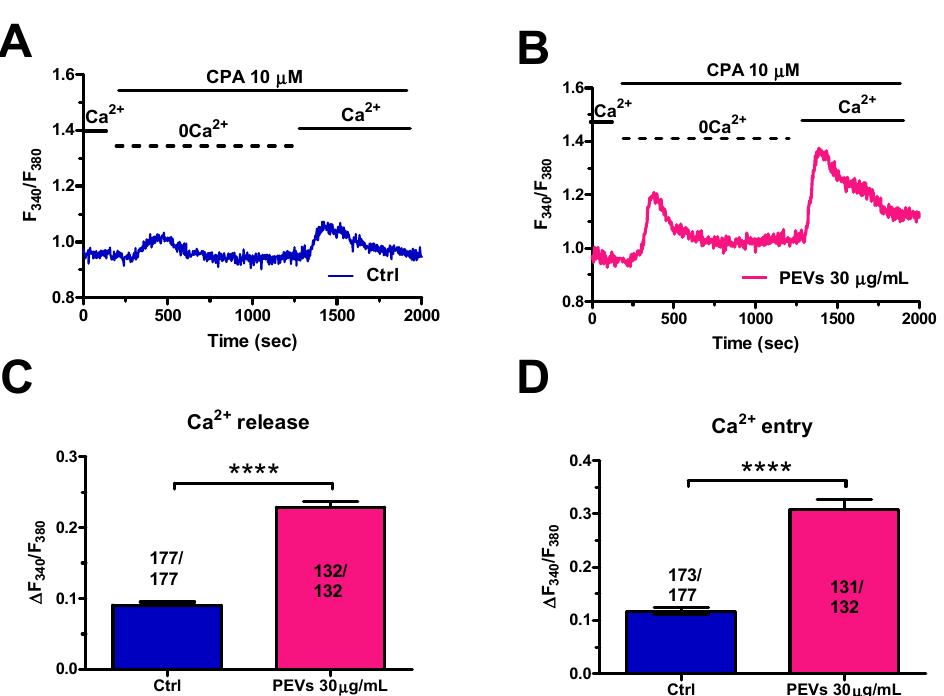
Figure 1. Long-term exposure of MDA-MB-231 cells to PEVs increases ER Ca 2+ mobilization and SOCE activation. ( A ). Control (Ctrl) cells were challenged with CPA (10 μ M), a selective SERCA inhibitor, in the absence of extracellular Ca 2+ (0Ca 2+ ). This manoeuvre caused a transient increase in [Ca 2+ ] i due to the depletion of the intracellular ER Ca 2+ store. The restoration of extracellular Ca 2+ induced a second increase in [Ca 2+ ] i , which is representative of SOCE. ( B ). Cells treated for 24 h with PEVs (30 µ g/mL) showed a higher Ca 2+ transient when stimulated with CPA under 0Ca 2+ conditions. Likewise, the restoration of extracellular Ca 2+ induced an enhanced increase in [Ca 2+ ] i that is indicative of a greater SOCE. ( C ). Mean ± SEM of the CPA-dependent intracellular Ca 2+ mobilization in control and PEV-treated cells. **** indicate p < 0.0001. ( D ). Mean ± SEM of the CPA-dependent SOCE amplitude in control and PEV-treated cells. **** indicate p < 0.0001. The migratory mechanism in MDA-MB-231 cells exposed to chemotactic cues involves an initial phase of Ca 2+ release from the ER through InsP 3 Rs followed by SOCE activa- tion [26,30,31,52,53]. Adenosine triphosphate (ATP) represents an autocrine/paracrine mes- senger that has long been used to evaluate InsP 3 -dependent Ca 2+ signals in multiple types of cancer cells [23,40,53,54], including MDA-MB-231 cells [55,56]. ATP binds to G q -coupled P 2Y receptors, thereby stimulating phospholipase C β (PLC β ) to cleave phosphatidylinositol- 4,5-bisphosphate (PIP 2 ) into diacylglycerol (DAG) and InsP 3 [23,40,54,57]. Preliminary experiments confirmed that ATP-evoked intracellular Ca 2+ release was mediated by InsP 3 Rs (Figure S2). The Ca 2+ add-back protocol confirmed that both phases of the Ca 2+ response to ATP (100 µ M), i.e., intracellular Ca 2+ release through InsP 3 Rs and SOCE, were significantly enhanced in MDA-MB-231 pre-treated with PEVs for 24 h when compared to untreated (Ctrl) cells (Figure 2A–C). As described elsewhere [37,40,57], the agonist was removed from the perfusate 100 s before the re-addition of extracellular Ca 2+ to prevent the activation of second messengers-operated channels and ionotropic P 2X receptors. To circumvent the G q -protein-PLC β -InsP 3 signalling pathway, InsP 3 Rs were directly activated with a membrane-permeant esterified form of InsP 3 , known as InsP 3 -BM (1 µ M) [58]. The Ca 2+ add-back protocol showed that InsP 3 -BM-evoked ER Ca 2+ mobilization and SOCE were significantly larger in MDA-MB-231 pre-treated with PEVs for 24 h when compared